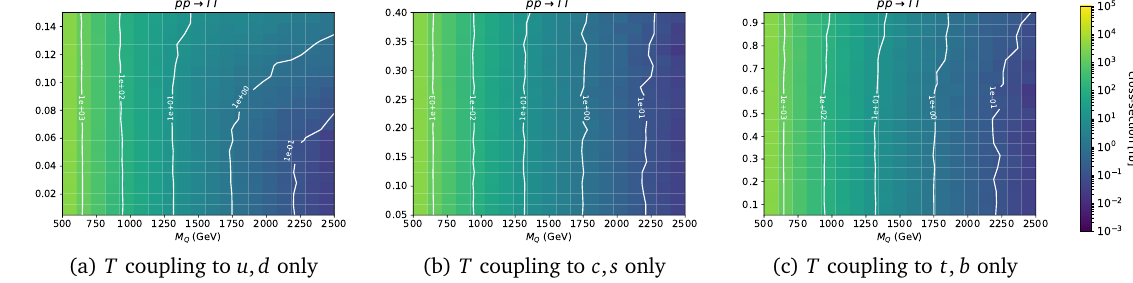
Figure 2: Leading-order cross-sections extracted from Herwig for production of a T T pair as a function of M and κ , for 13 TeV pp collisions, in the W : Z : H = 1 Q scenario, assuming couplings to individual generations of quarks. The white lines indicate the contours for production cross-sections in multiples of 10. The first- generation cross-sections acquire a dependence on κ since pair-production initiated by proton valence quarks becomes possible. The situation is analogous for other VLQ flavours, although somewhat attenuated for X and Y since they still require at least one antiquark from the sea to be produced via W exchange in the t